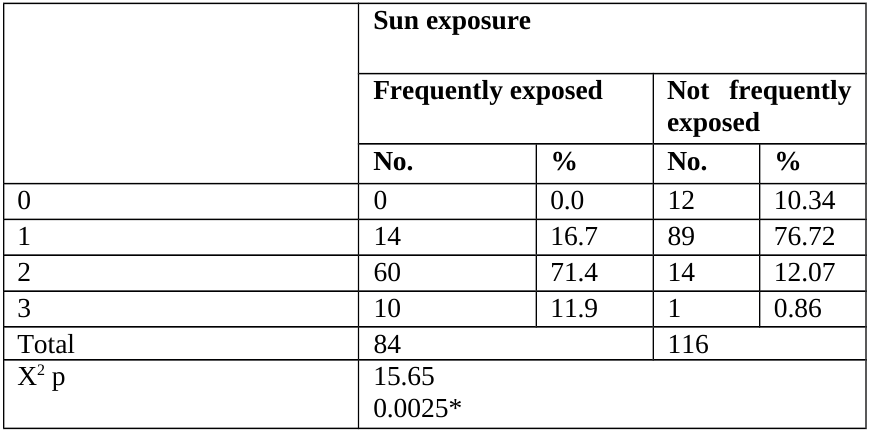
Table (10): Relation between GAAS in group I at end of follow up and nature of acne.